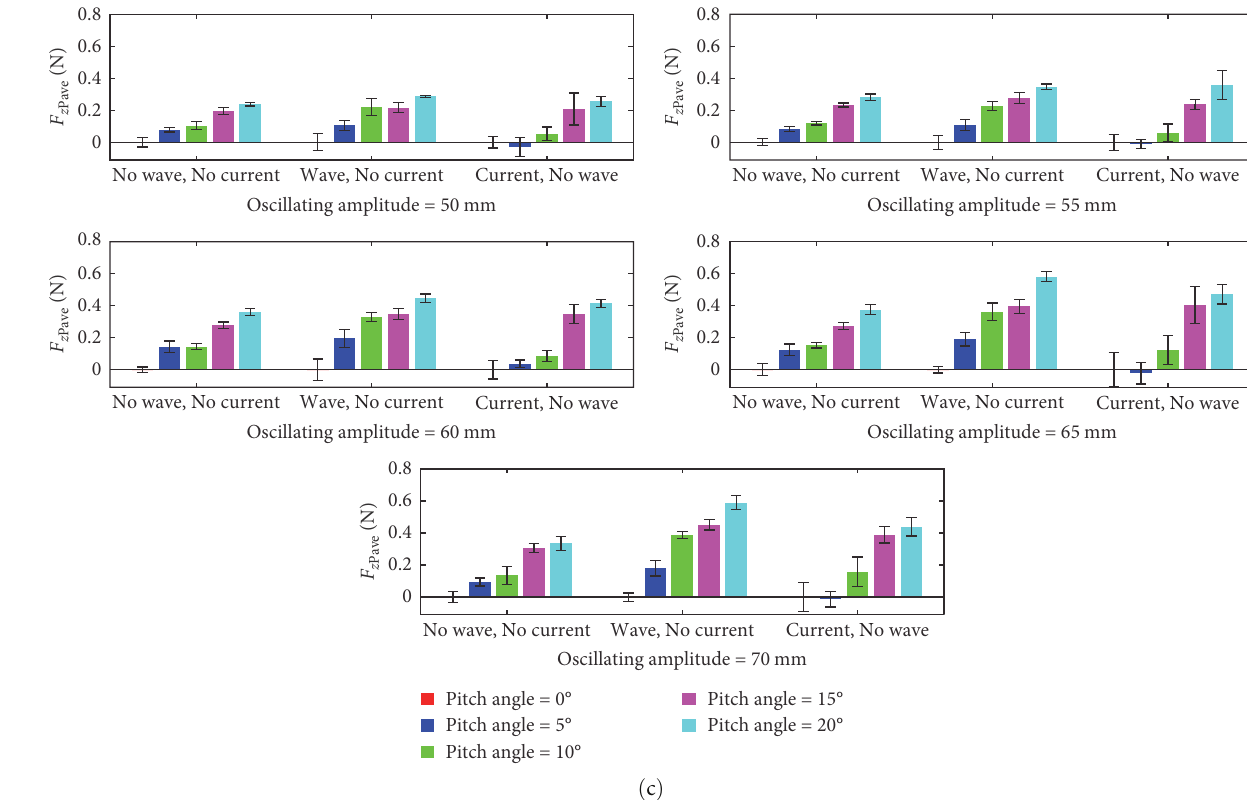
F IGURE 11: F xP ; F yP , and F zP with various pitch angles over environmental